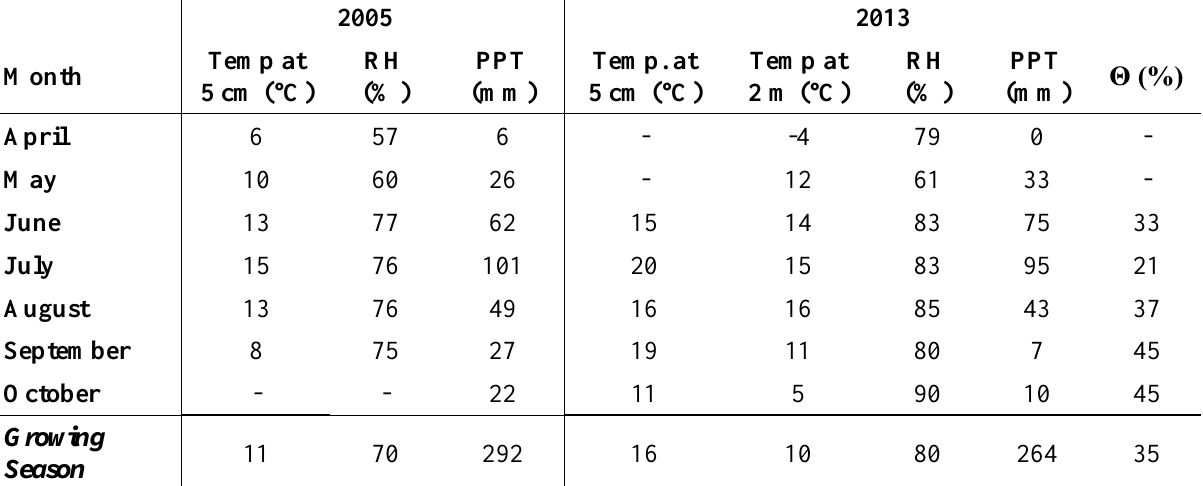
Table 1. Mean values for weather conditions, air temperature, relative humidity, and precipitation, in 2005 and 2013. Temp = air temperature at height above ground, PPT = precipitation, RH = relative humidity, Ɵ = volumetric water